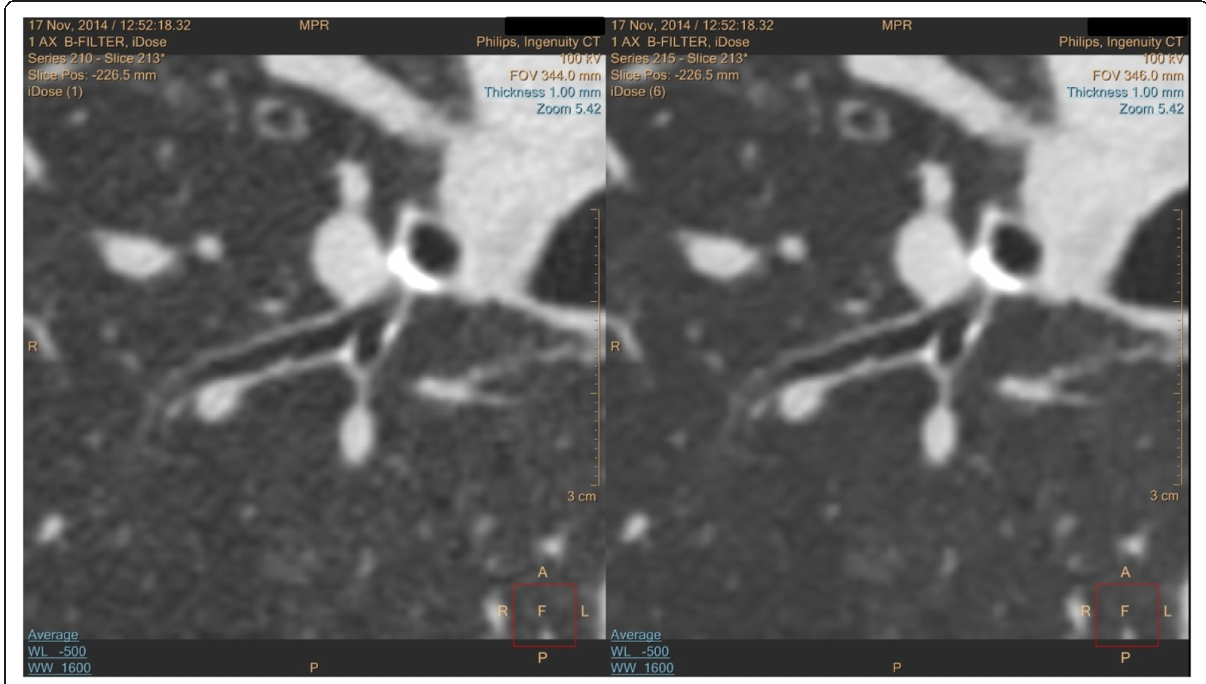
Fig. 2 Magnification of Fig. 1, left: iDose 4 level 1 and right iDose 4 level